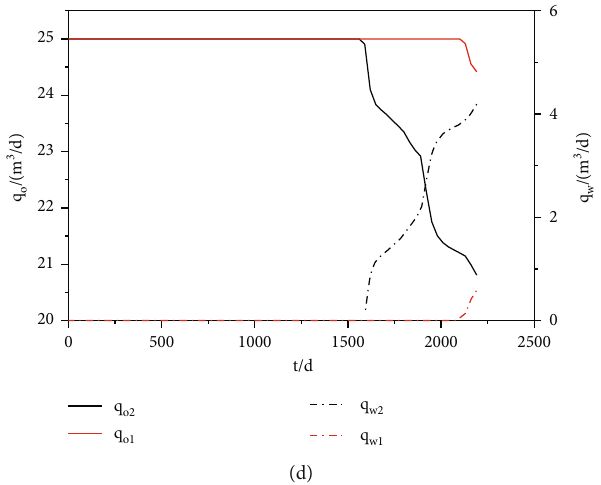
Figure 12: Numerical simulation of injection and production of adjacent horizontal wells: (a) diagram of meshes; (b) permeability distribution; (c) diagram of water saturation; (d) daily production and daily water production of di ff erent